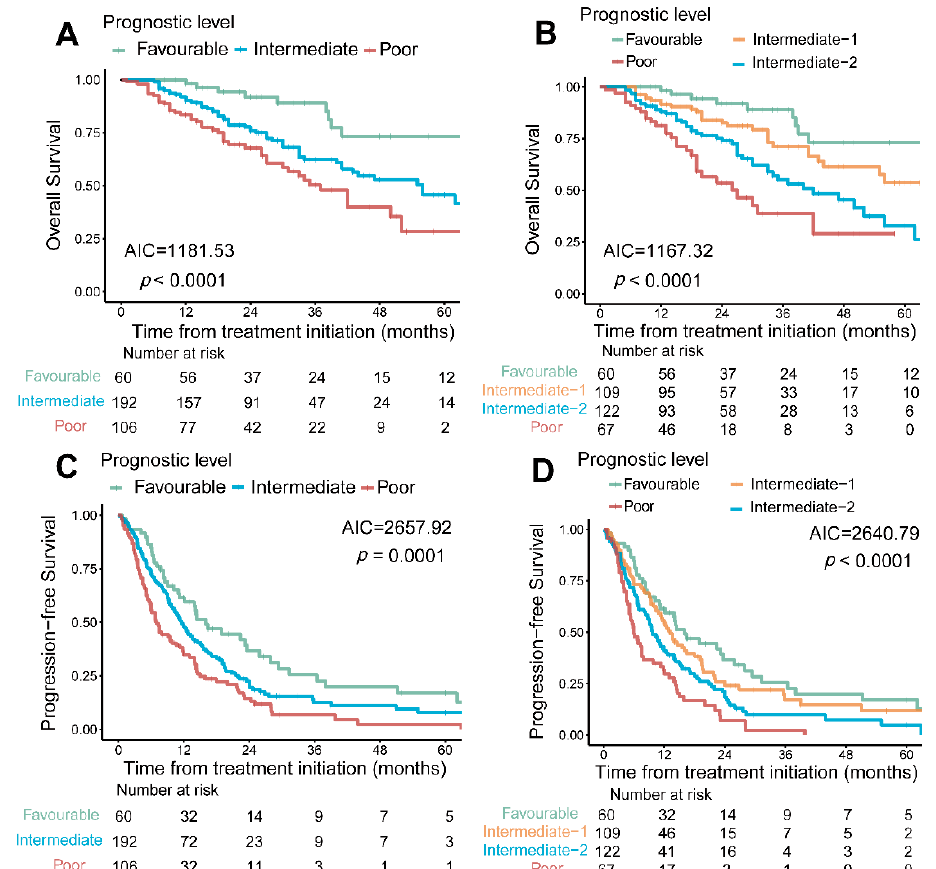
Figure 3. PRFT-modified IMDC risk model compared with traditional IMDC risk model. Traditional IMDC model including six risk factors: TDT, Karnofsky performance status, neutrophil, platelets, corrected serum calcium, hemoglobin. Combined with PRFT, we improved the traditional IMDC model. PRFT-modified IMDC risk model divided patients into four risk groups: favorable (0 risk factor), intermediate-1 (1–2 risk factors and higher PRFT), intermediate-2 (1–2 risk factors but PRFT ≤ median; more than 2 risk factors but PRFT > median), poor (more than 2 risk factors and PRFT ≤ median). PRFT-modified IMDC risk model showed higher differentiating degree in predicting OS (A,B) and PFS (C,D) comparing with traditional IMDC risk model. IMDC: International Metastatic Renal-Cell Carcinoma Database Consortium . PRFT: perirenal fat thickness; OS: overall survival; PFS: progression-free survival; TDT: time from diagnosis to treatment.